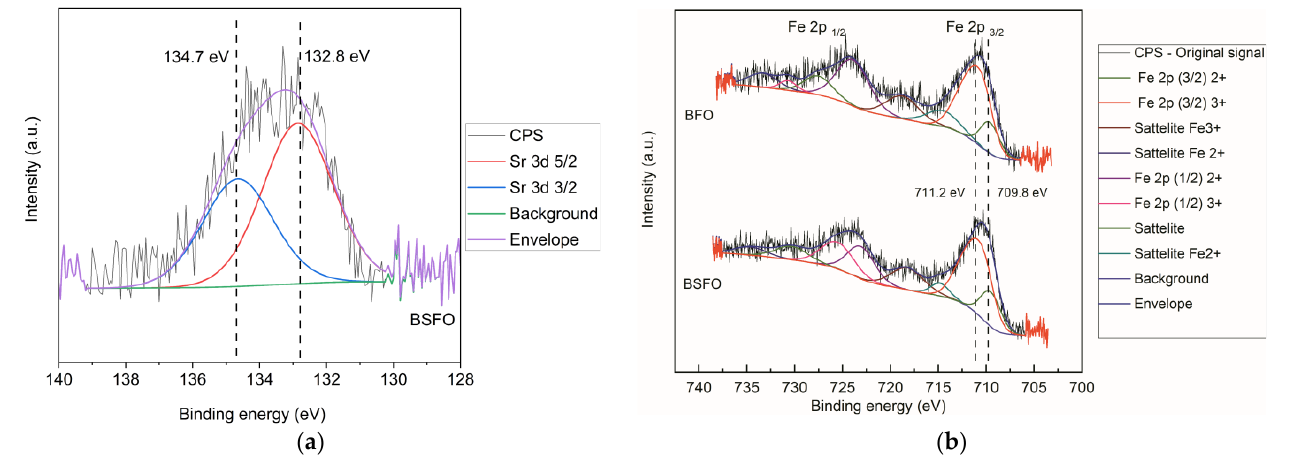
Figure 5. XPS high resolution scans. ( a ) Sr 3d of BSFO. ( b ) Fe 2p of BFO and